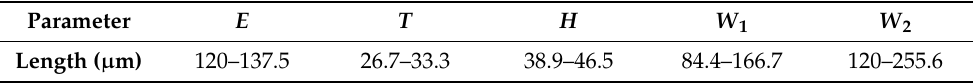
Figure 1. SEM images and sample of dragonfly’s front wing leading edge. ( a ) Serration structure of A area leading edge. ( b ) Serration structure of B area leading edge. ( c ) Serration structure of C area leading edge. ( d ) Cross-section of the leading edge. ( e ) Dragonfly’s front wing. Table 1. Parameters of leading-edge wing vein microstructure ( µ